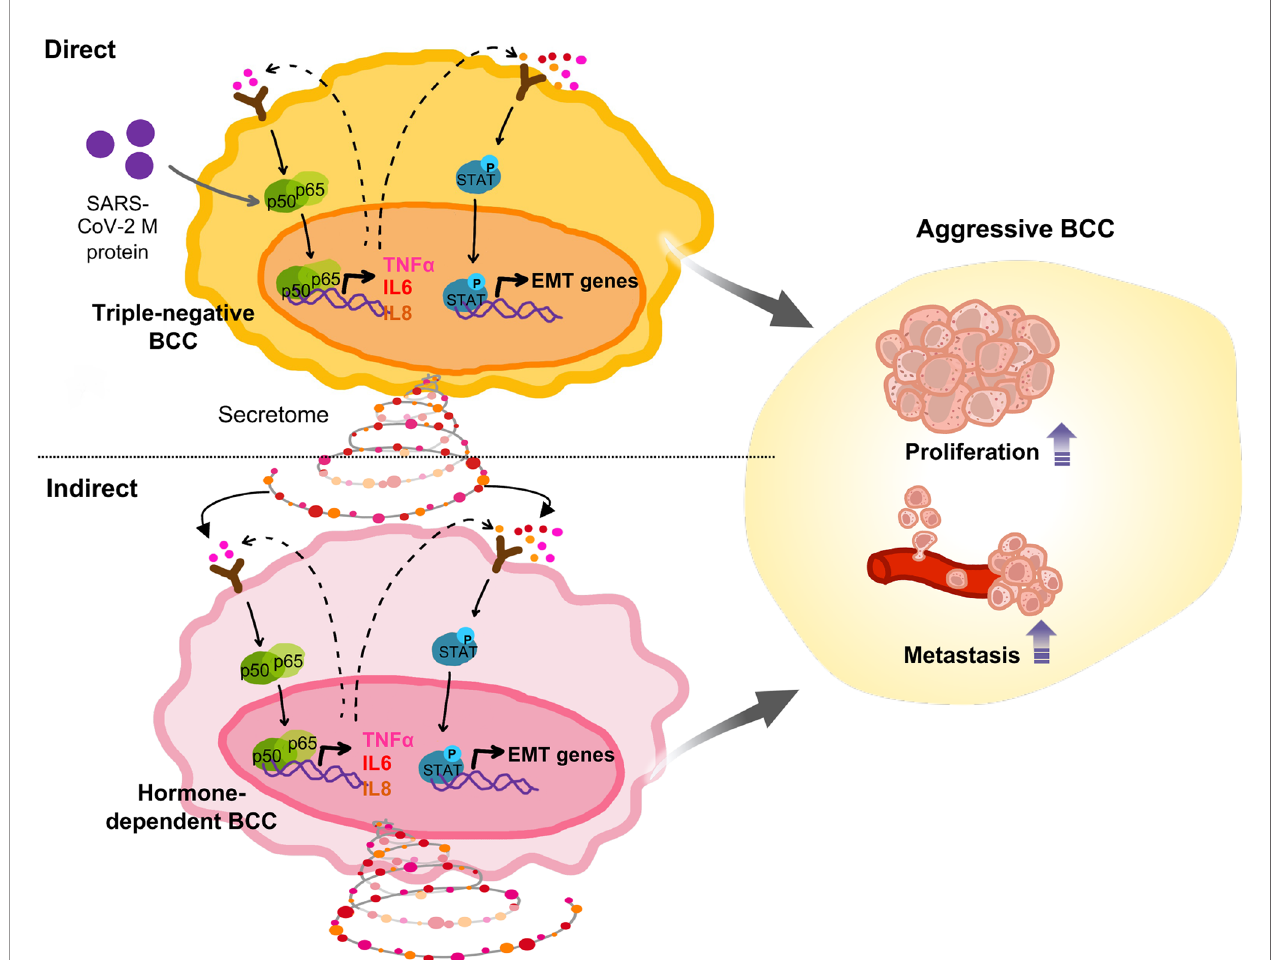
FIGURE 5 | Proposed model: In TNBC cells, SARS-CoV-2 M protein activated the NF k B and STAT3 signaling pathways, which are involved in mobility, proliferation and stemness, thereby facilitating in vivo metastasis. In addition, SARS-CoV-2 M protein-treated TNBC cells caused malignant transformation of non-aggressive